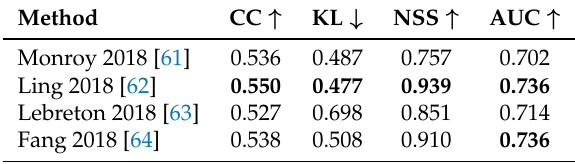
Table 4. Quantitative comparison of selected methods for saliency estimation in omnidirectional images, on the Salient360! challenge dataset. Best results are highlighted in boldface.